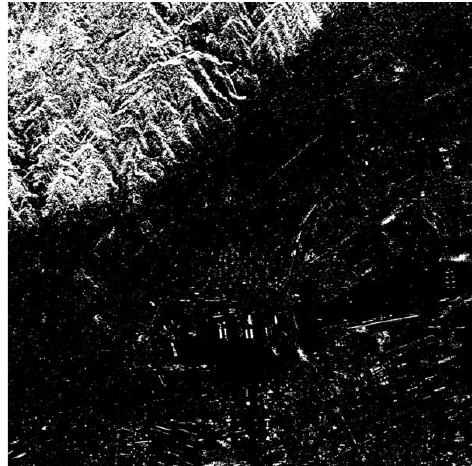
Figure 4. Classification result using (cid:13) HH;V V before closing in study area